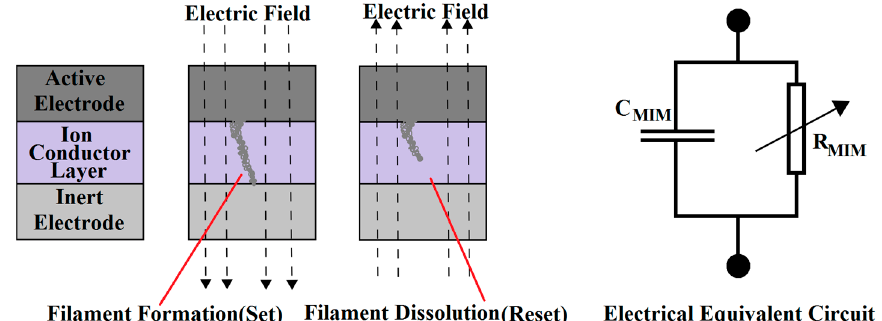
Figure 1. Layer architecture of metal–insulator–metal (MIM) cell showing the filament formation and dissolution, along with the electrical equivalent circuit.